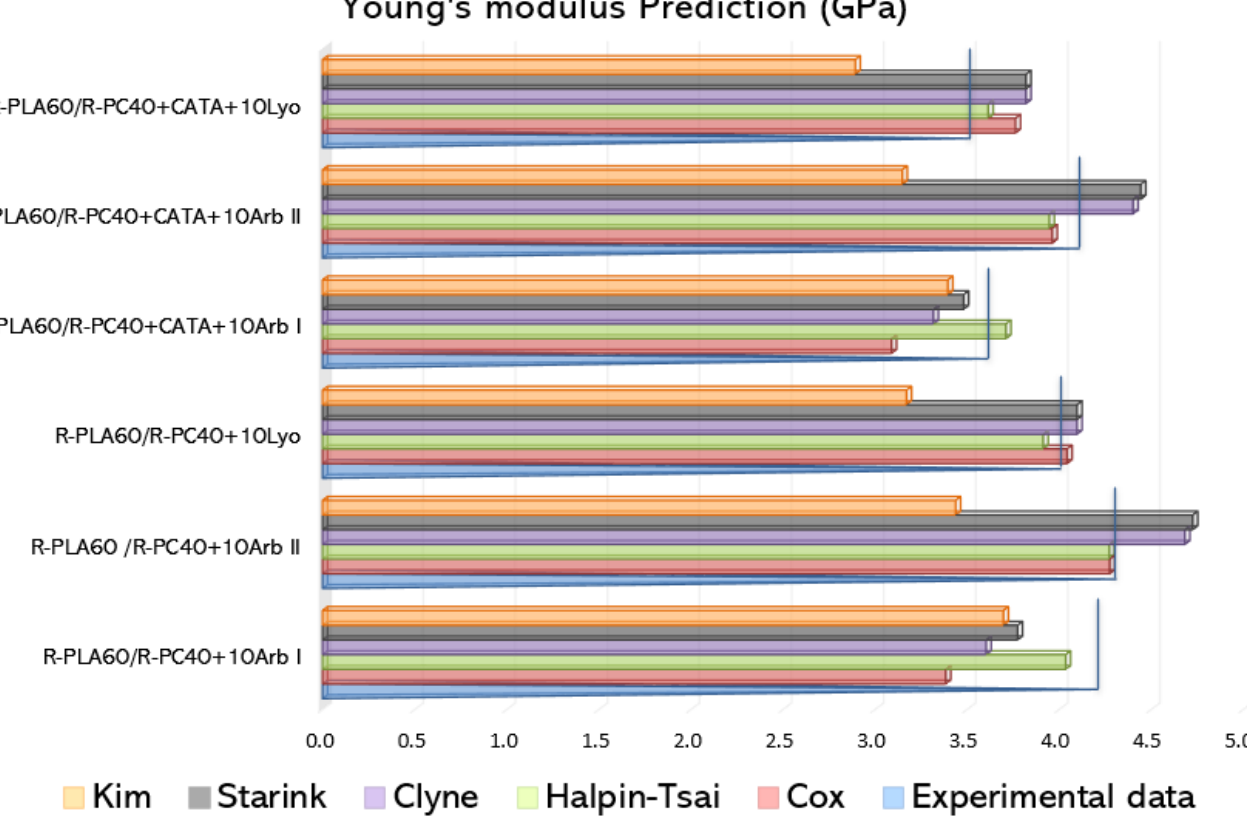
Figure 5. General summary and comparison of predictive models/experimental data.